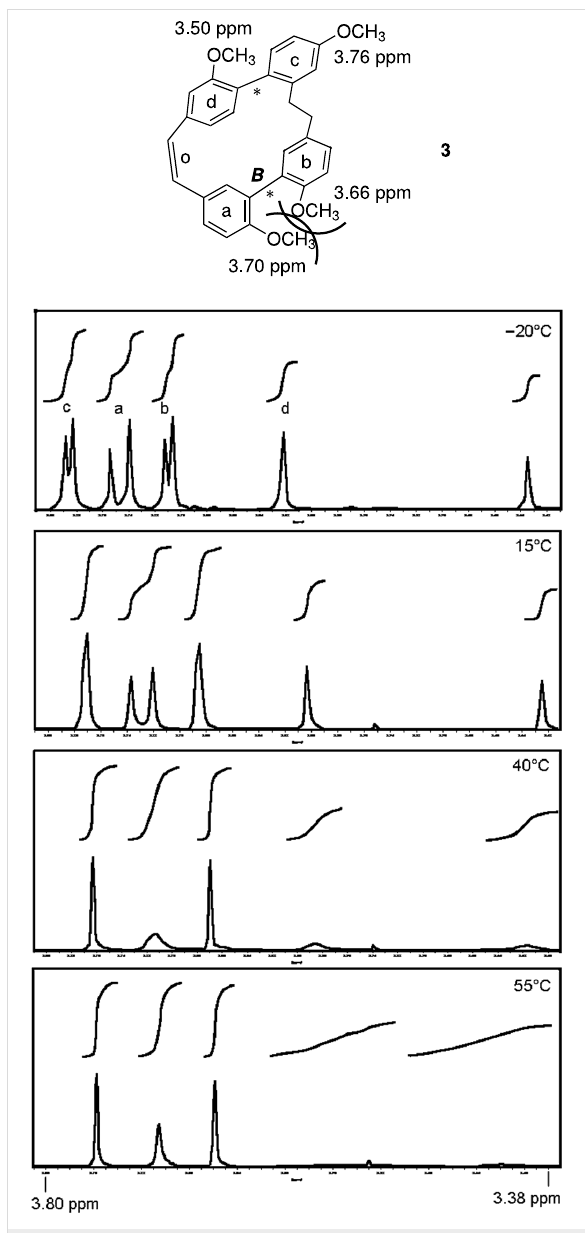
Figure 3: Temperature dependent 1 H NMR and assignment of methoxy signals in the tetramethyl ether 3